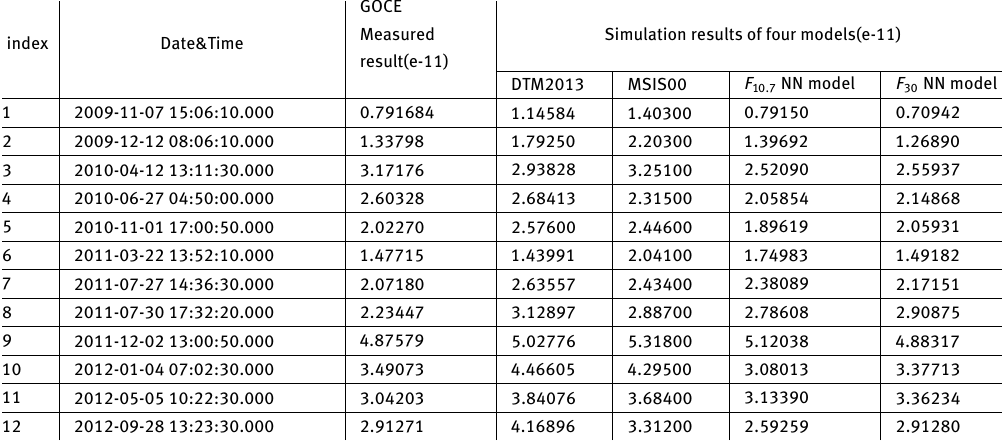
Table 2. The GOCE measured result and Simulation results of four models